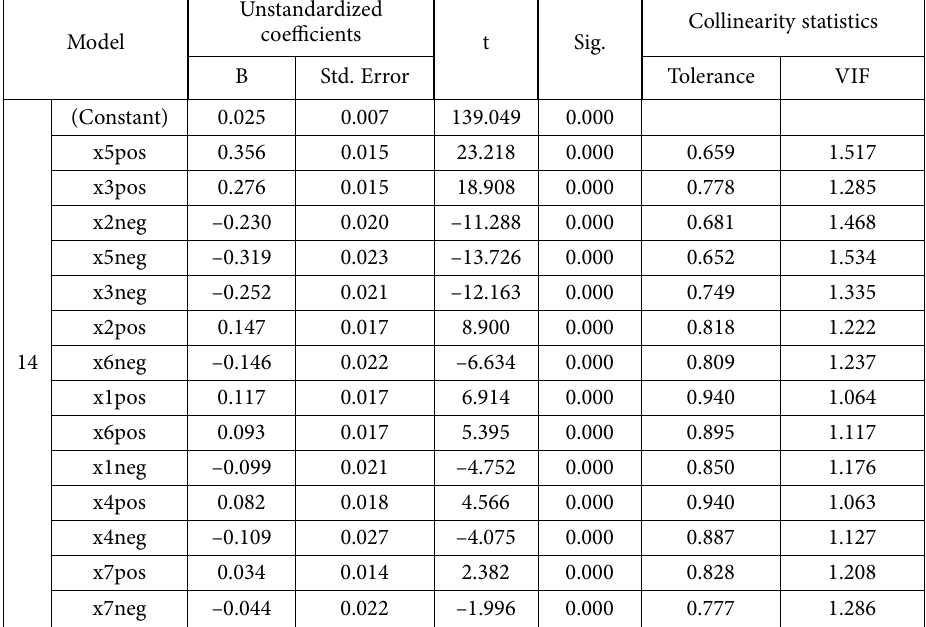
Table 11. The coefficients of the final regression